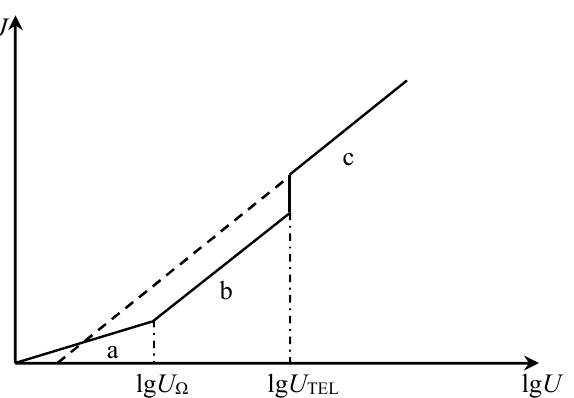
Figure 5. Relationship between space charge limited current in dielectrics and the applied voltage. (a region—Linear region is Ohmic conduction current region; b region—Calder’s law region of space charge limited current when trapped; c region—Calder’s Law region with trap filling or without